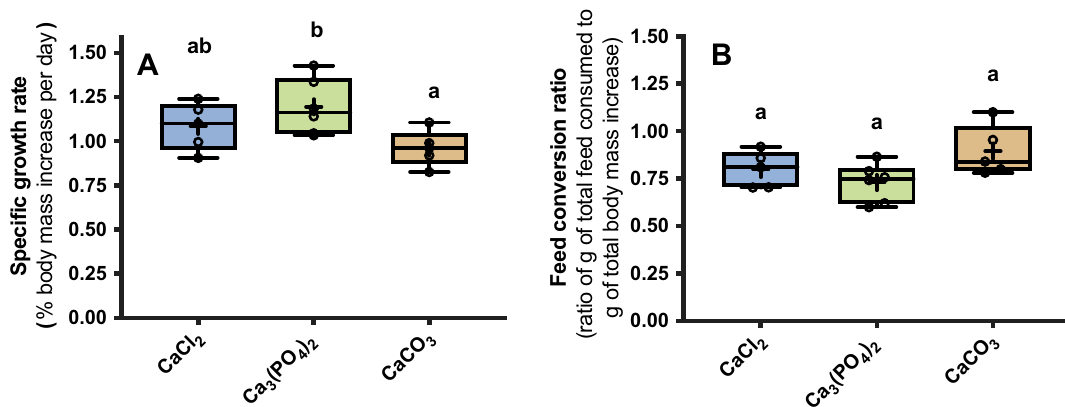
Figure 7. The average specific growth rate (SGR) (A) and feed conversion ratio (FCR) (B) of juvenile rainbow trout ( Oncorhynchus mykiss ) fed a daily 1% ration of three experimental feeds ( N = 5 for CaCl 2 and CaCO 3 treatments; n = 6 for Ca 3 (PO 4 ) 2 treatment) over a 21 day period. Data are presented as a six number summary: minimum, first quartile (Q1), median (horizontal line), mean (+), third quartile (Q3) and the maximum. Open circles represent values from each individual. Different letters (abc) indicate statistical significance between groups following a one-way ANOVA and Tukey’s multiple comparisons test. Significance was accepted at P <